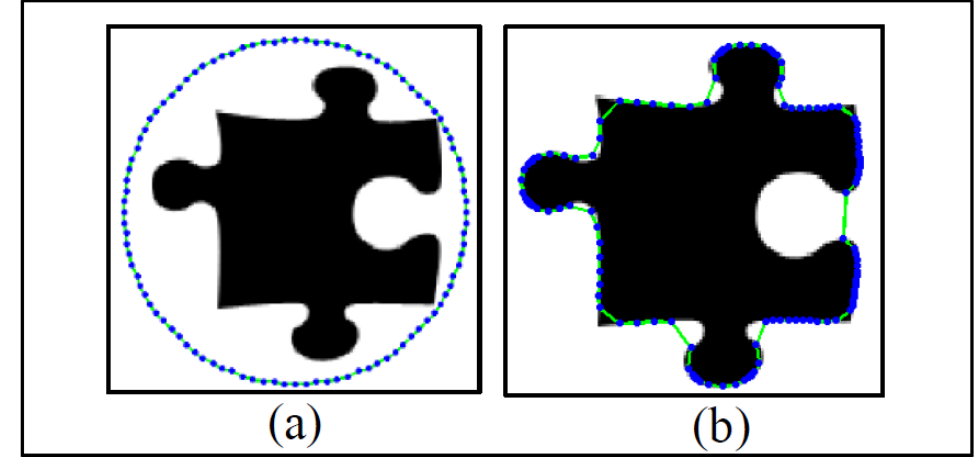
Figure 3. An example of concave regions; ( a ) is the initial snake and ( b ) is the final state of snake (by Kass) occurred after 2346